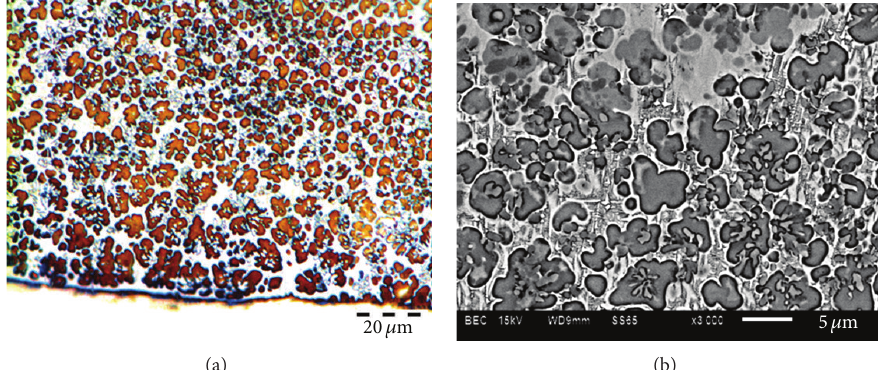
Figure 4: Micrographs of the laser deposited Ti55Ni45 coating; (a) optical image indicating different phases within the coating; (b) SEM image showing high magnification of the coating.